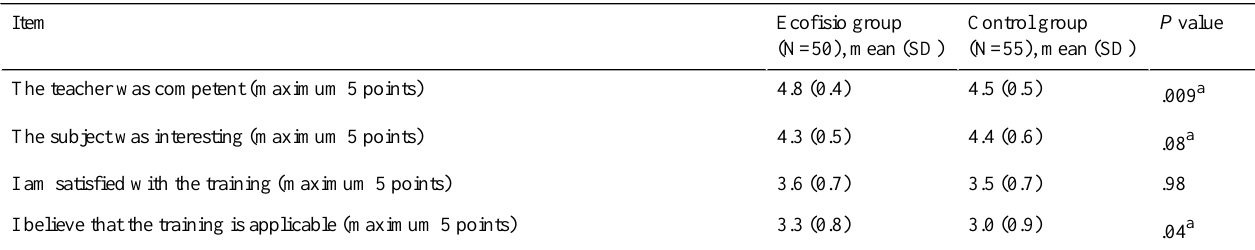
Table 3. Differences between groups regarding training